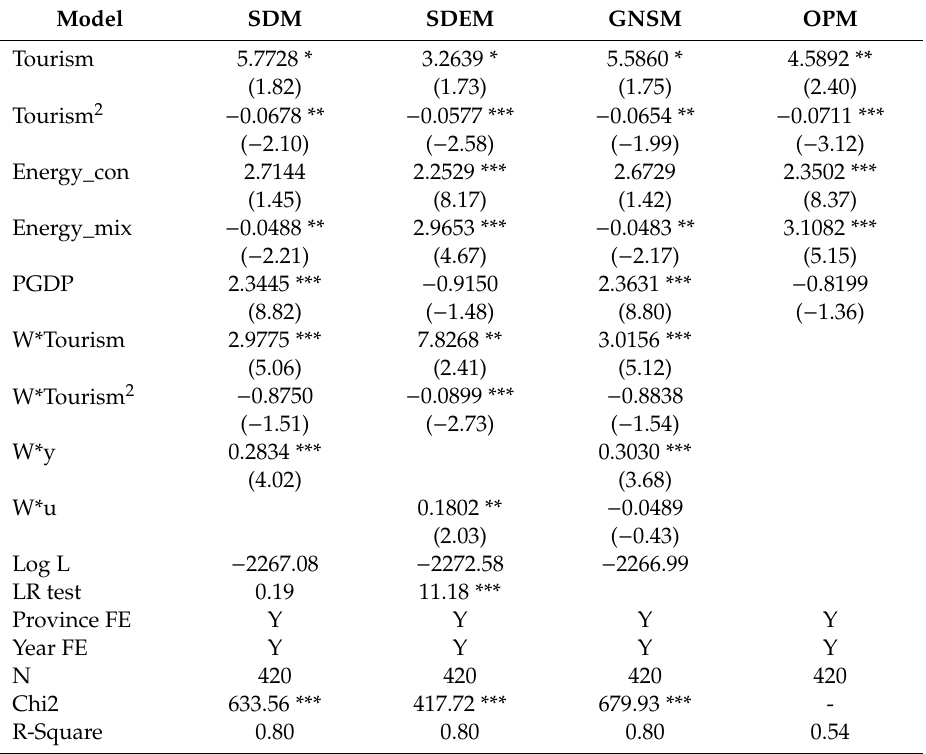
Table 3. Estimation results of the impact of tourism on carbon